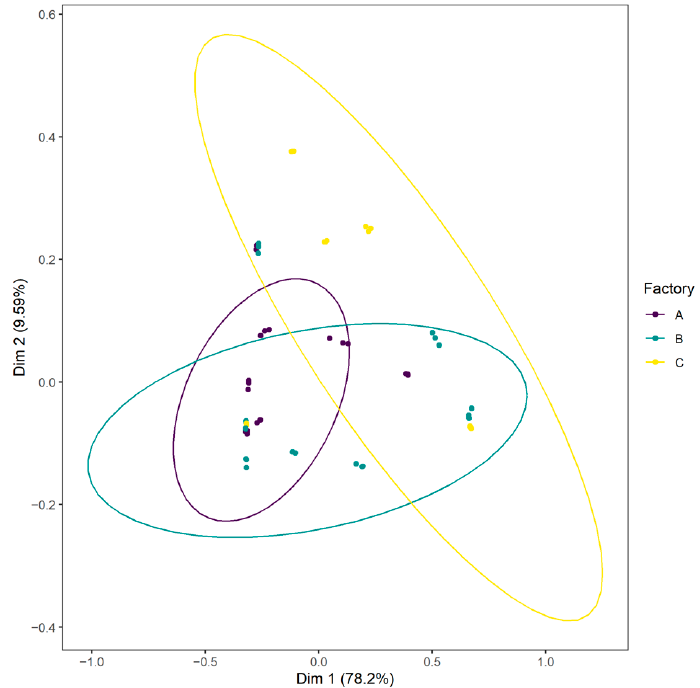
Figure 7. Weighted UniFrac principal coordinates analysis (PCoA) plot of CSS samples according to the food processing factory. Table 2. Observed richness and evenness for 16S rRNA amplicons analyzed in this study. Data are expressed in Mean ±